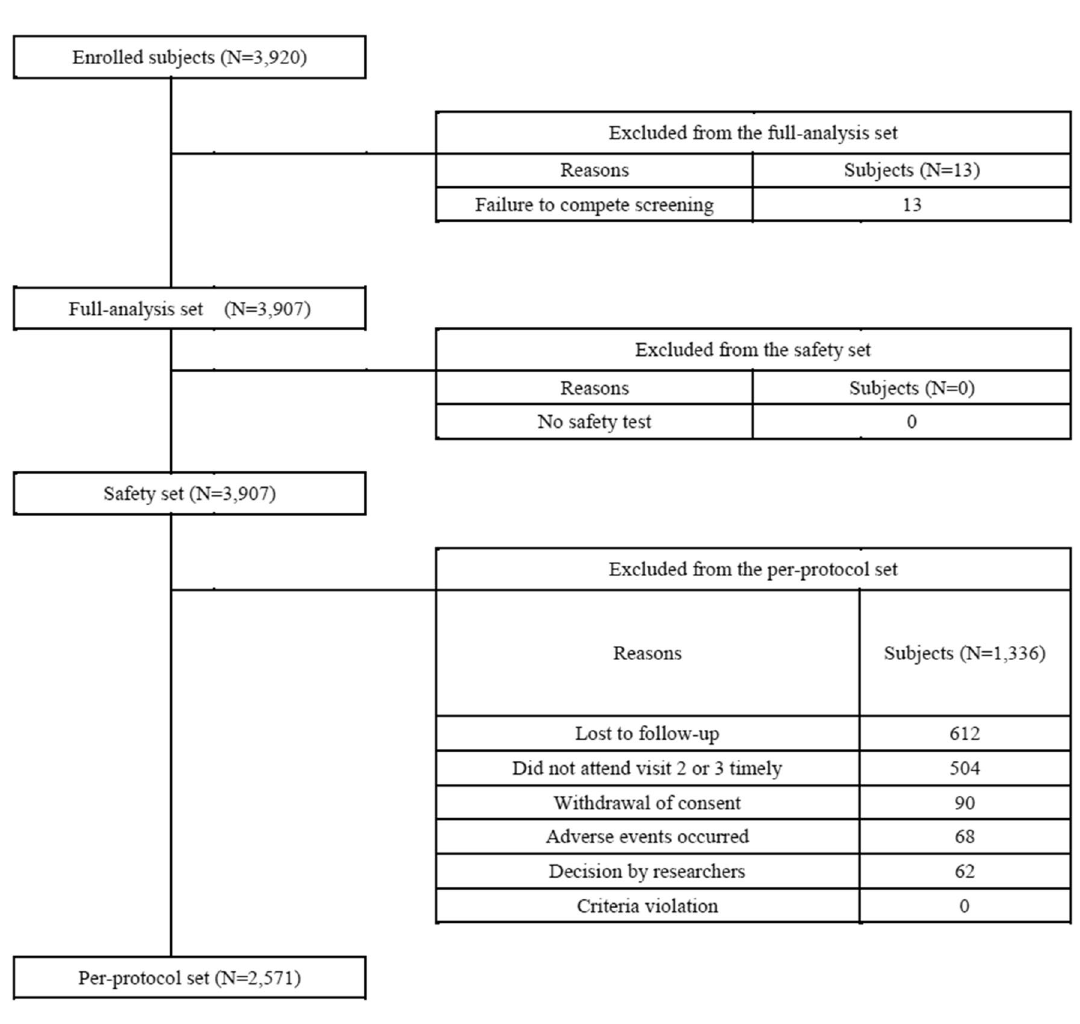
Figure 1. Flow chart of study